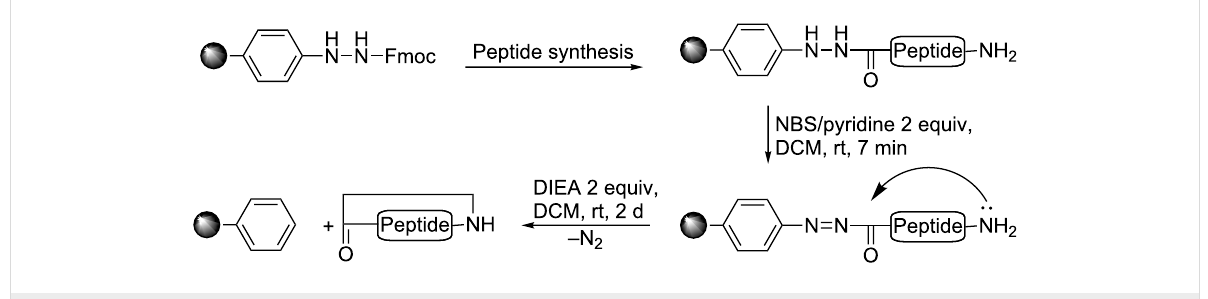
by solution-phase chemistry [8,9]. Purification by chromatogra- phy is required after each coupling step, and the final cycliza-